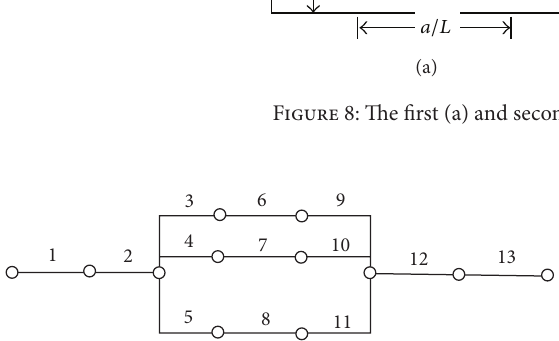
Figure 9: Mesh discretization for double-delaminated configura-